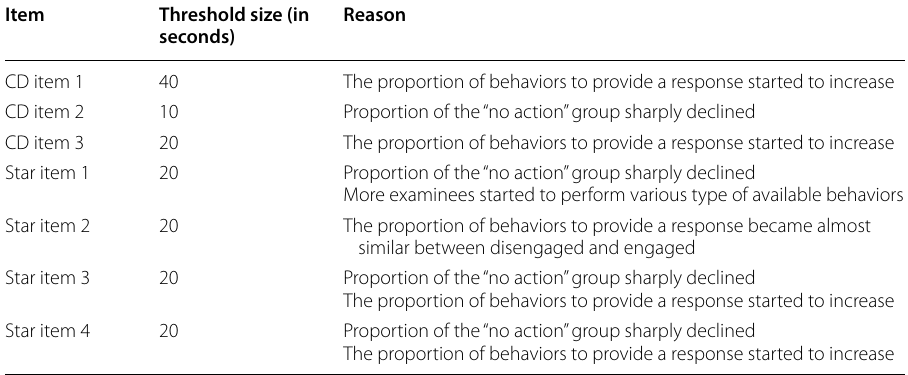
Table 2 Suggested thresholds based on the guidelines for using response behaviors to decide threshold